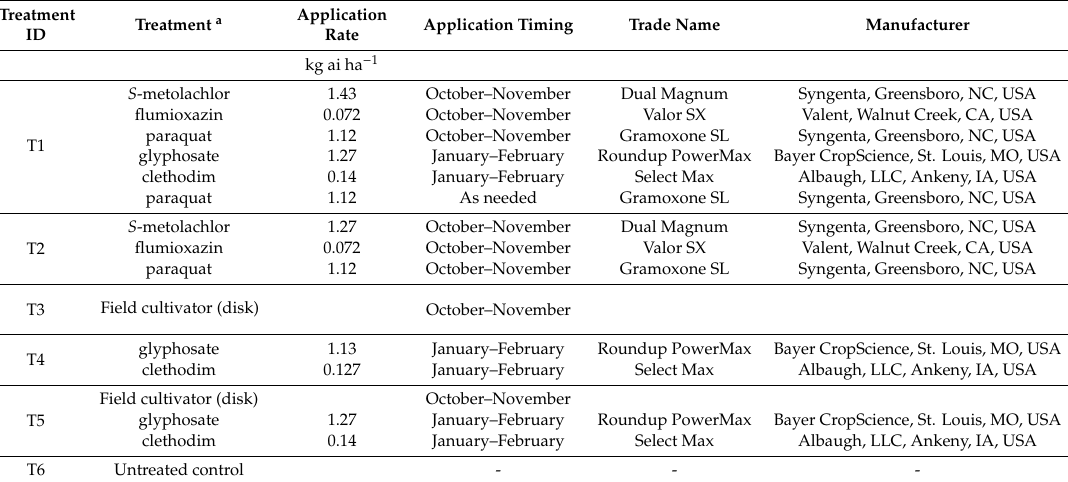
Table 2. Herbicide treatment programs for the glyphosate-resistant Italian ryegrass control and seed suppression in the field experiment at Stoneville, Mississippi in